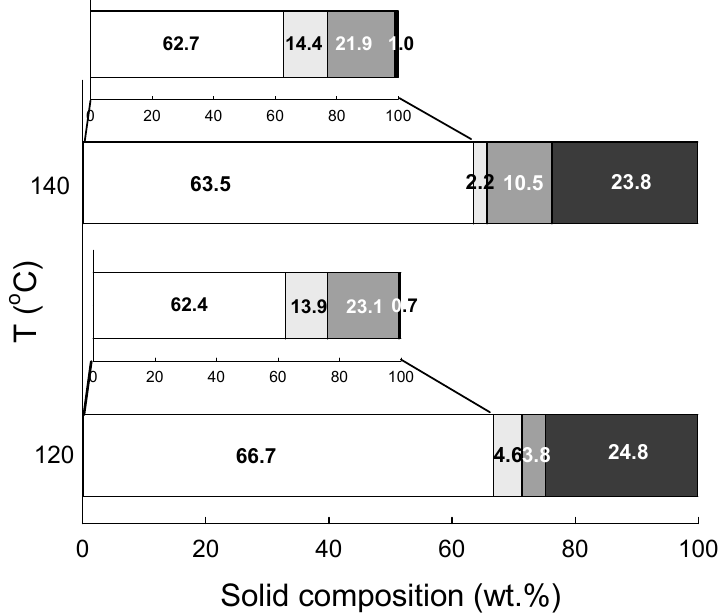
Figure 7. The cellulose- (white bar), hemicellulose- (light grey bar), and Klason lignin-rich (dark grey bar) fractions obtained from eucalyptus residues pre-treated with [emim][OAc] at 120 °C and 140 °C and 2 h. Inserts present the composition of cellulose- and hemicellulose-rich fractions (the same colours were used to differentiate each individual component). Numbers presented in the figure indicate the composition (expressed in wt.%). For exact values, refer to Table S2 in the ESI. Black bars correspond to other non-identified components and were calculated as the difference between biomass used for process or characterised fraction and cellulose, hemicellulose and lignin.